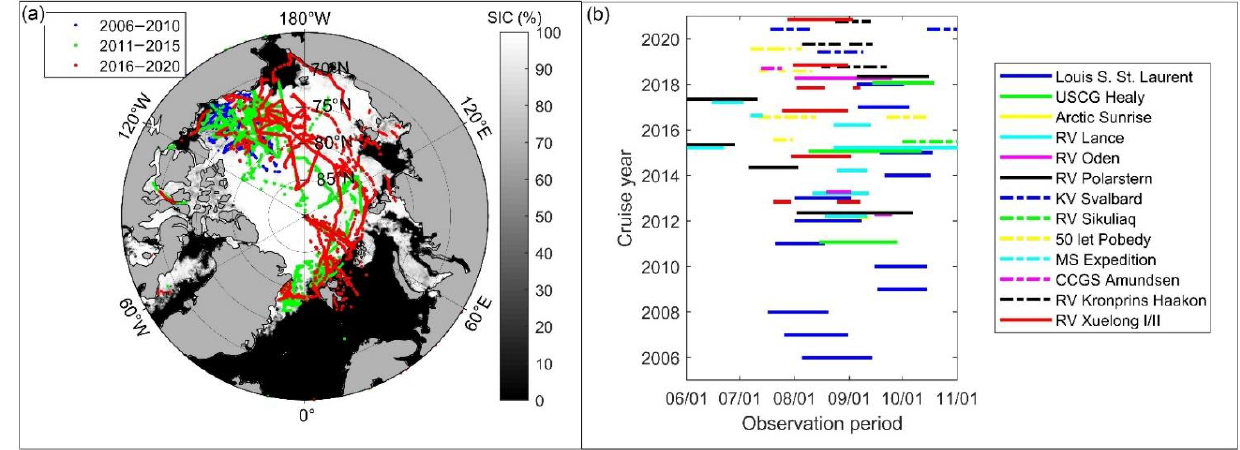
Figure 1. ( a ) Illustration of the trajectories of the 60 Arctic cruises used in this study, with blue denoting 2006–2010, green denoting 2011–2015, and red denoting 2016–2020. The background image is sea ice concentration on 1 July 2018. ( b ) The temporal distribution of the 60 Arctic cruises was 2006–2020. The different colors and line types represent the different vessels, which correspond to Table 1. Table 1. A list of the 60 Arctic cruises used in this study from Ice Watch and Xuelong I/II, including the cruise year, vessel names, flag country, and ship-based observation periods.